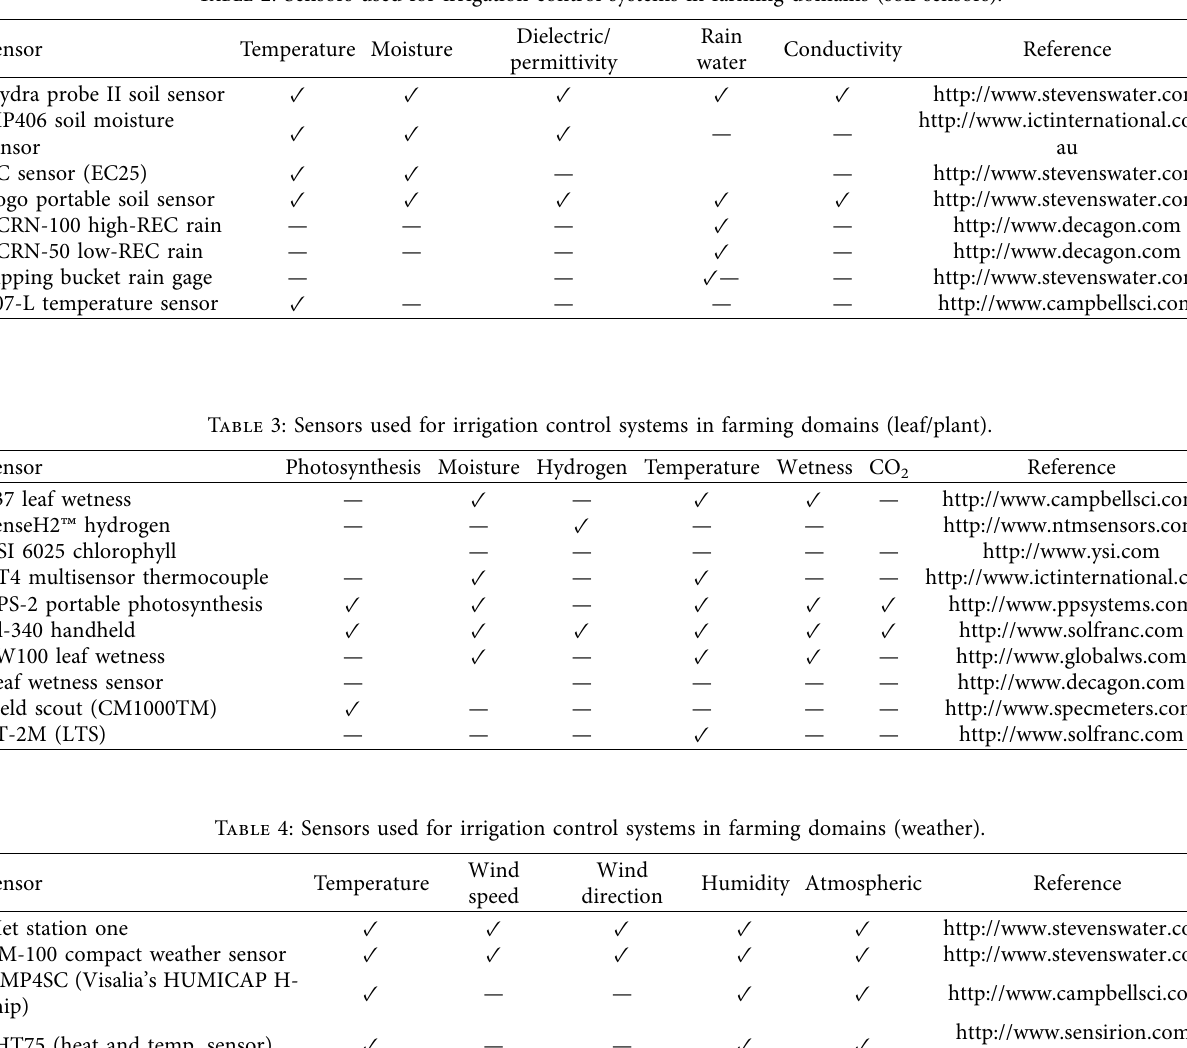
Table 2: Sensors used for irrigation control systems in farming domains (soil sensors).